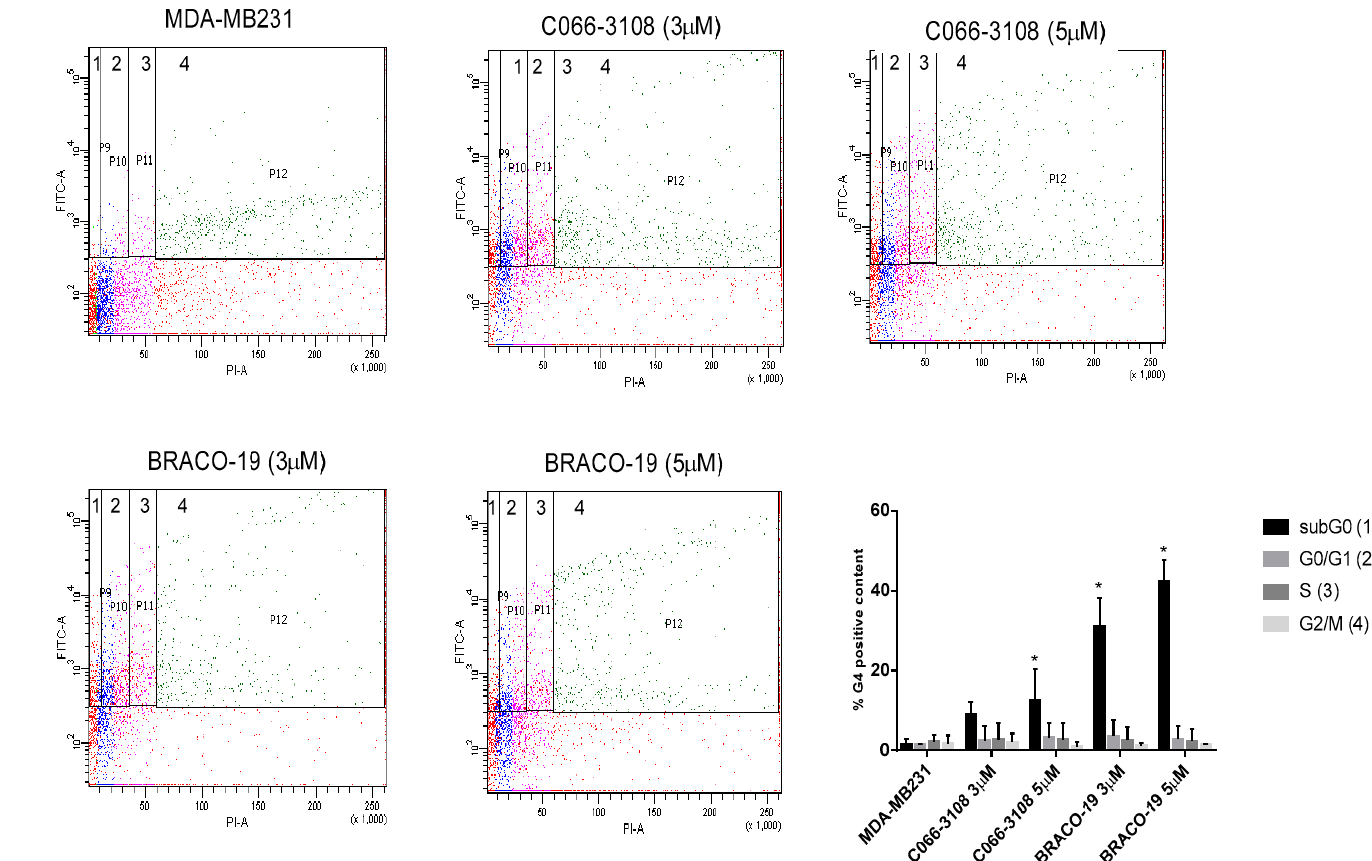
Figure 7. G4 ligand stabilization of G4 structures. G4 ligand stabilization in MCF-7 ( A ) and MDA-MB231 ( B ) cells was evaluated by flow cytometry detecting by gating strategies in each phase of the cell cycle on PI positive cells (PI-W versus PI-H dot plot) the percent of G4 structure positivity. Flow cytometry profiles representative of a single experiment are reported, whereas the histograms represent the mean ± SD of five independent experiments. The statistical significance was calculated by GraphPad Prism 7 with two-way ANOVA with Dunnett’s multiple comparisons test (* p < 0.05).